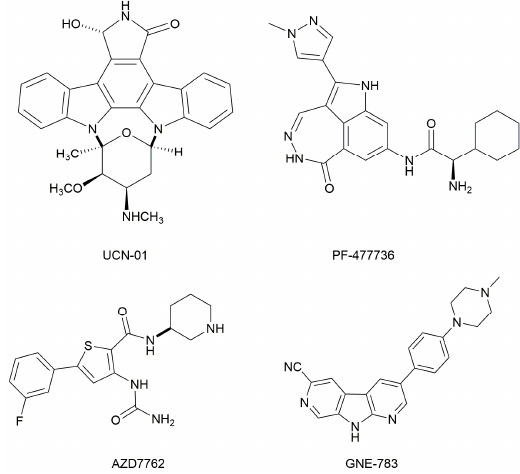
Figure 1. The protein Chk1 inhibitors.